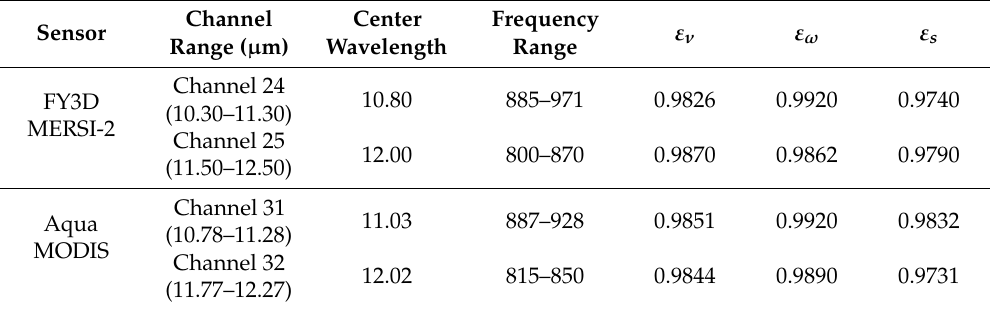
Table 3. Sensor characteristics commonly used for retrieving LST.